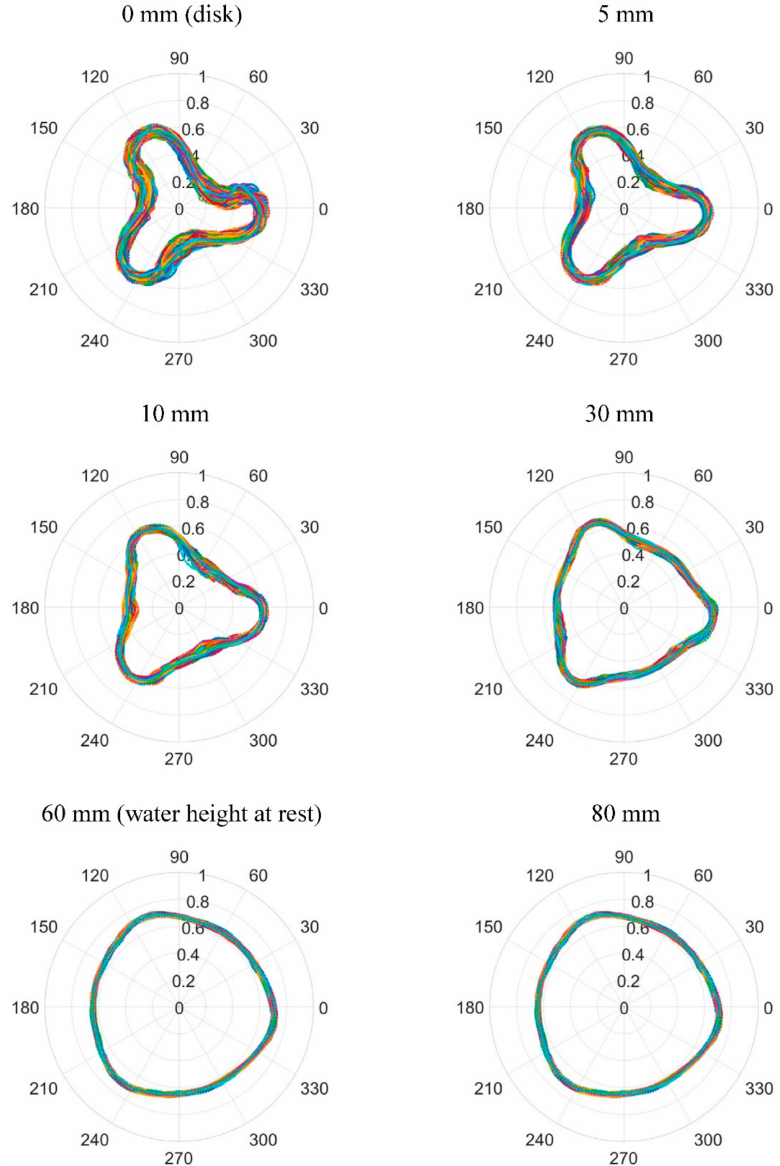
Figure 7. Free surface contours at six levels for 4.6 Hz disk rotation frequency. Each contour is rotated to the contour of t = 0 s using maximum correlation between the shapes. For each height 360 contours are plotted, representing results for 36